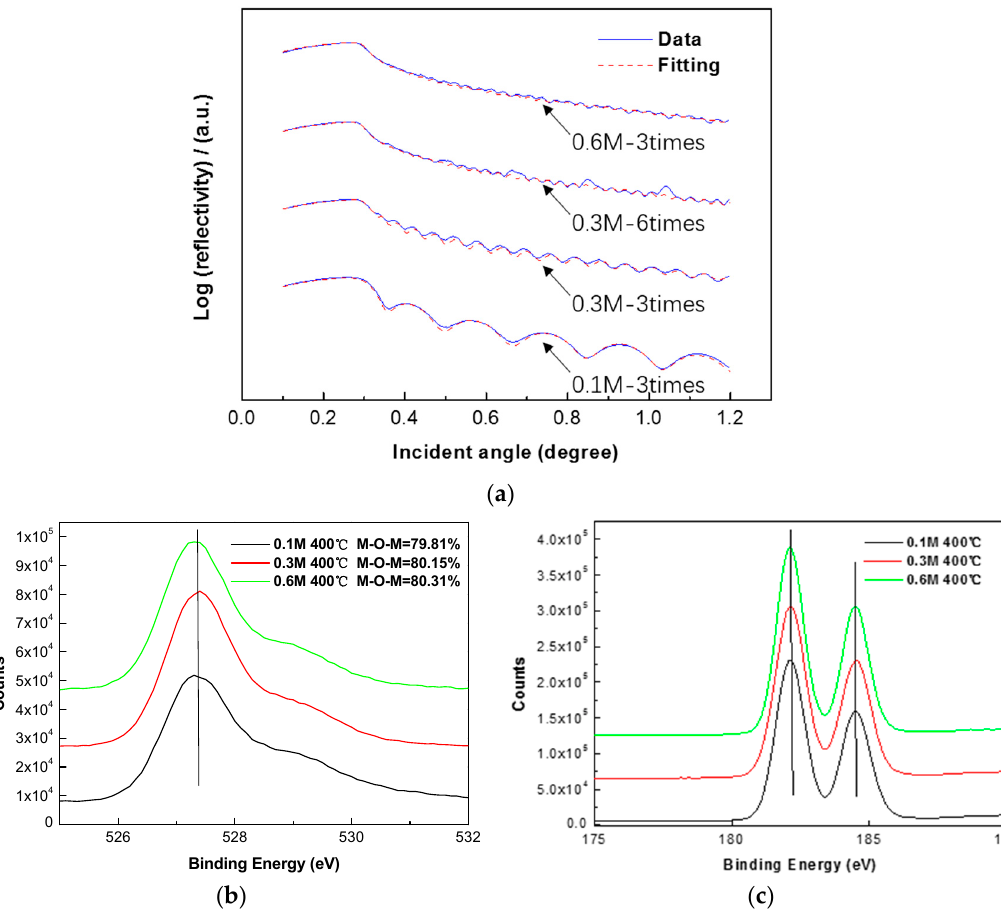
Figure 5. ( a ) X-ray reflectivity measurements of 0.1 M, 0.3 M, and 0.6 M precursor-based ZrO 2 film of different coating times; ( b ) O 1s spectra; ( c ) Zr 3d spectra of ZrO 2 films from 0.1 M, 0.3 M, and 0.6 M precursor.